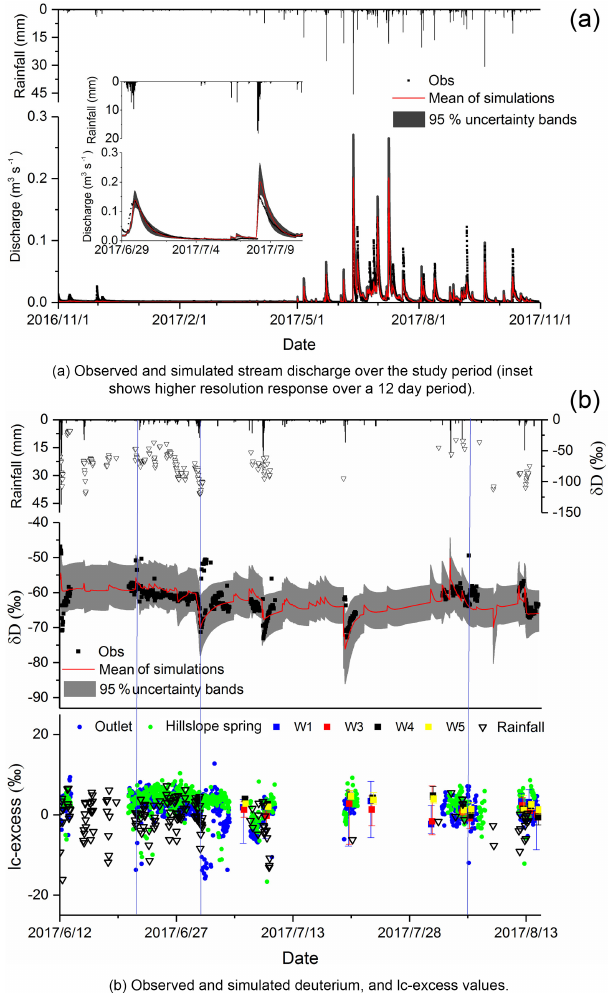
Figure 4. Observed stream discharge and deuterium during the study period, discharge and deuterium simulations for the best 500 parameter sets, and lc-excess values of rainfall, outlet, hillslope spring and depression